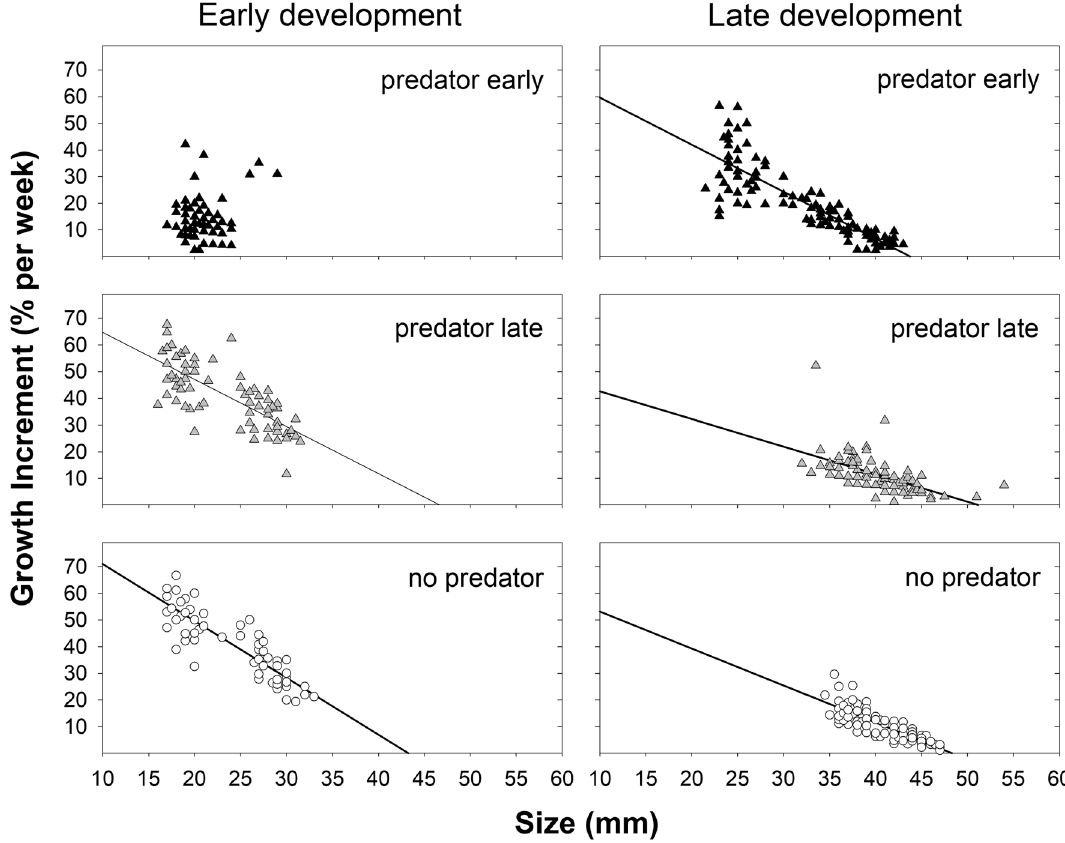
Figure 4. Relationship between growth increment and size throughout two intervals of development. PE treatment—early development: regression NS (p = 0.14), PE treatment—late development: GI (growth increment) = −1.76 size + 77.24, R-square = 0.73; PL treatment—early development: GI = −1.77 size + 82.37, R-square = 0.56, PL treatment—late development: GI = −1.03 size + 52.87, R-square = 0.34; control—early